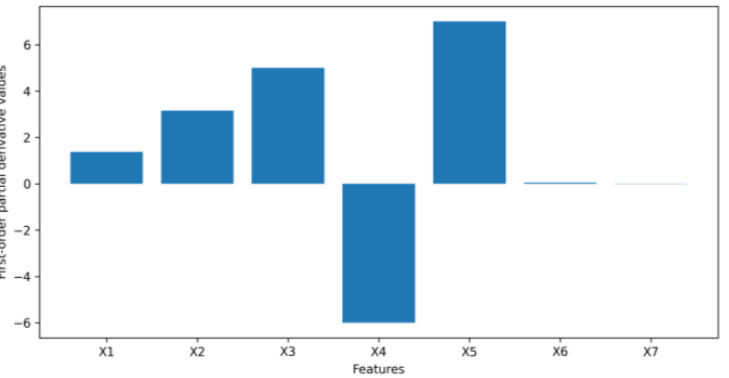
Figure 6. Sensitivity values for simulated data.